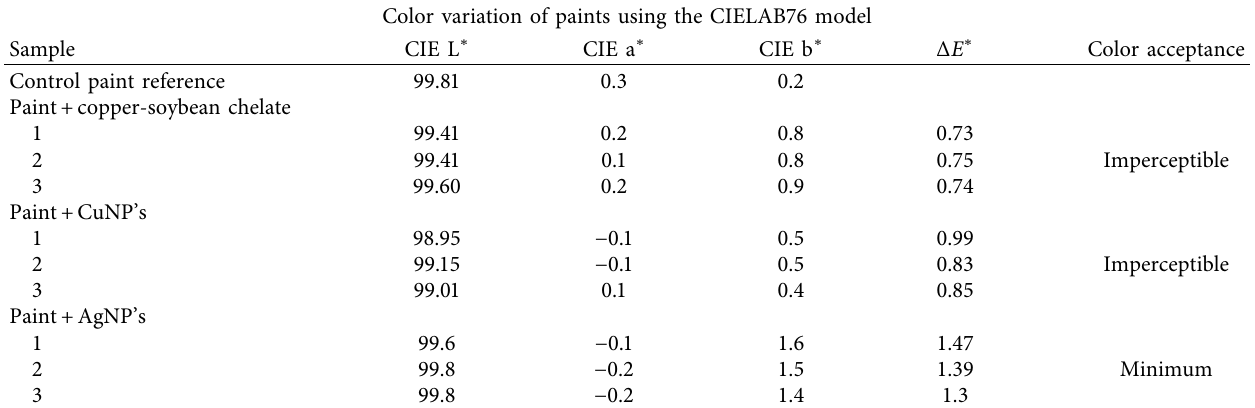
Table 2: Color variation of the paint samples.